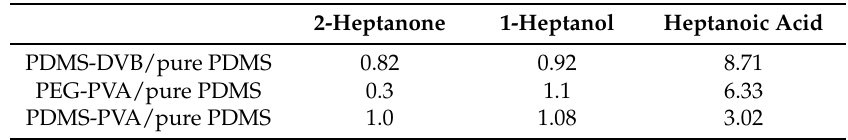
Table 2. Adsorption specificity of composite adsorbents. Adsorption amounts determined from the total ion current (TIC values) were normalized to the TIC values for adsorbed 2-heptanone on each adsorbent.